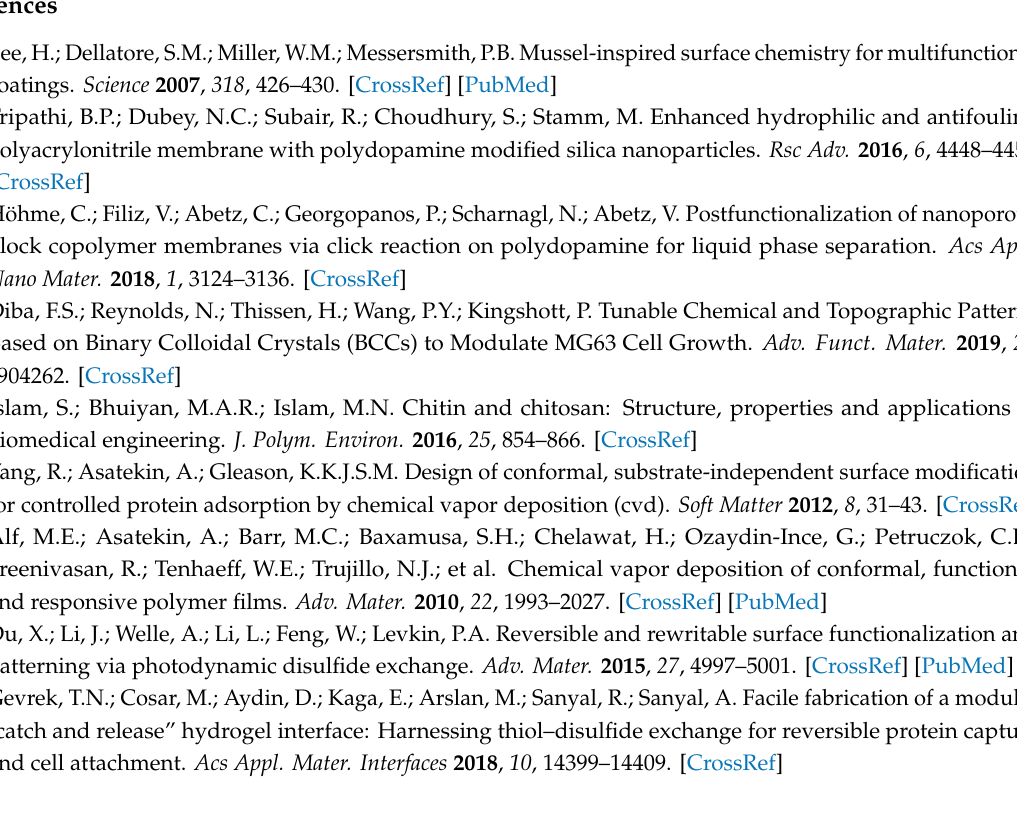
Figure S1: FT-IR spectra showing the thermal stability of the coating. Figure S2: Reaction e ffi ciency analysis of the erasable coating. Figure S2: Reaction e ffi ciency analysis of the erasable